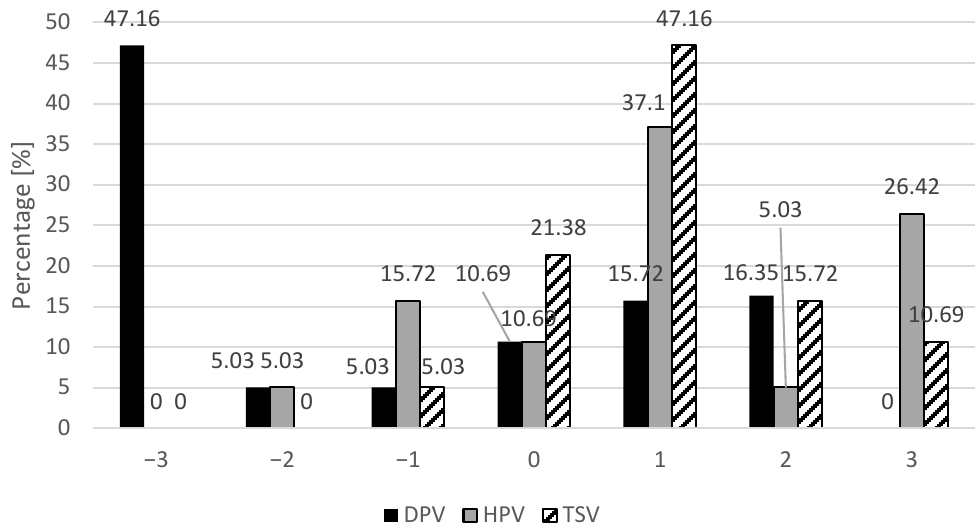
Figure 4. Evaluation of the indoor humidity perception vote (HPV), indoor draft perception vote (DPV), and thermal sensation vote (TSV).